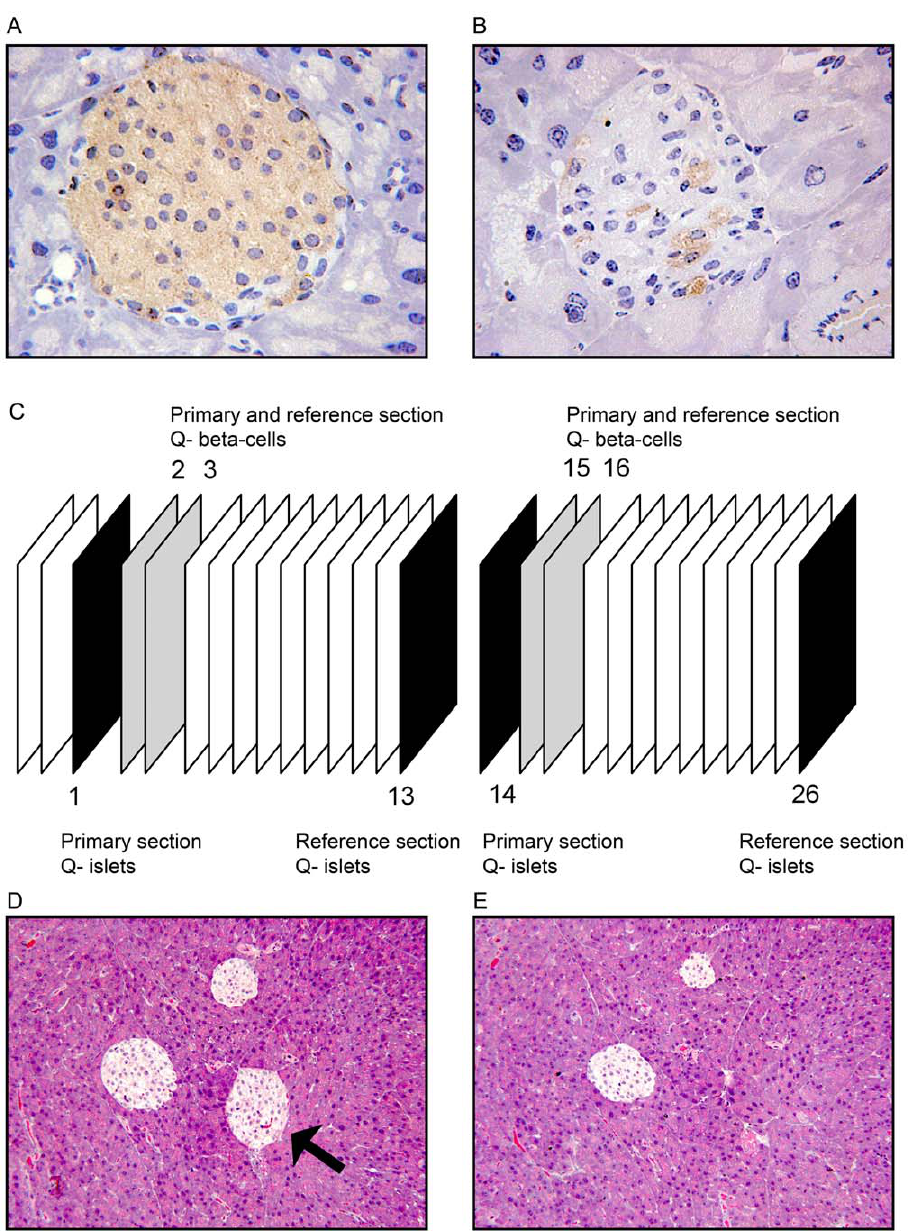
Figure 1. Representative islet profiles, sampling of sections, counting Q 2 islets. Example of an islet profile of a control (A) and a GIPR dn transgenic mouse (B) immunohistochemically stained for insulin; (C) Sampling scheme for drawing primary and reference sections; (D) Primary section and (E) reference section for counting Q 2 islets, one Q 2 may be counted in the example (arrow in E).